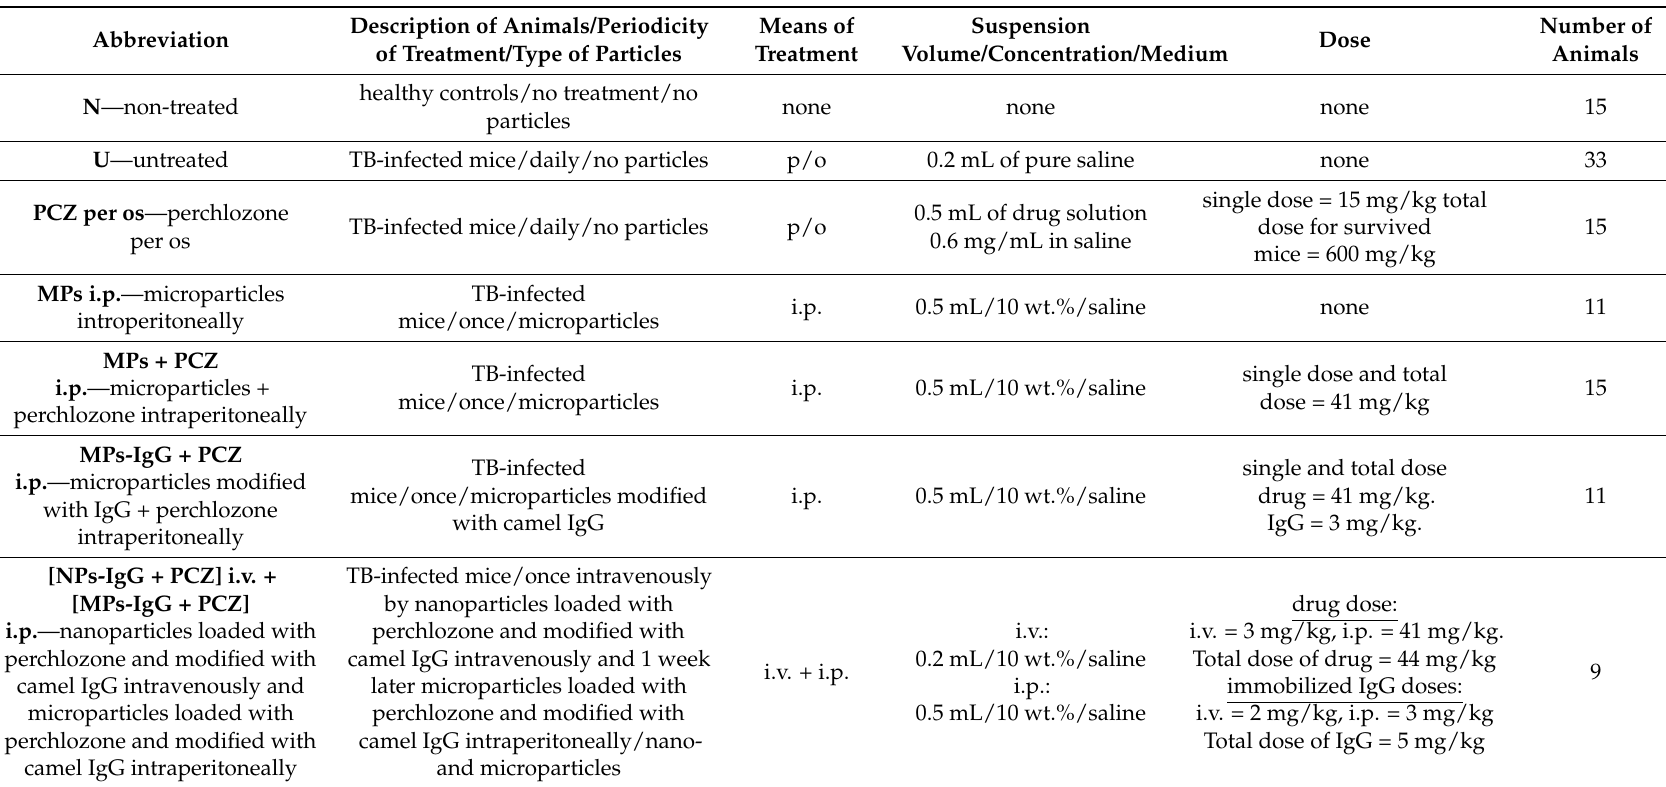
Table 1. The description of groups of mice involved in the experiment. Abbreviations: p/o—per os; i.p.—intraperitoneally; i.v.—intravenously; PCZ—perchlozone; IgG—immunoglobulin;